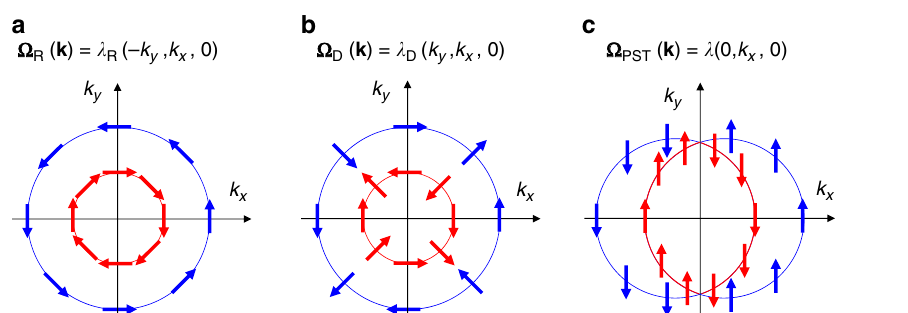
Fig. 1 Spin texture. a – c Spin structure resulting from spin-orbit coupling in a system lacking an inversion center: Rashba ( a ), Dresselhaus ( b ), and persistent spin texture ( c ) con fi gurations. Blue and red arrows indicate spin orientation for the two electronic subbands resulting from SOC. Expressions for the respective SOC fi elds Ω ð k Þ are shown. Note that Ω is represented in the coordinate system with the x - and y -axes being perpendicular to the mirror D planes of an orthorhombic system ( M x and M y in Fig. 2a)